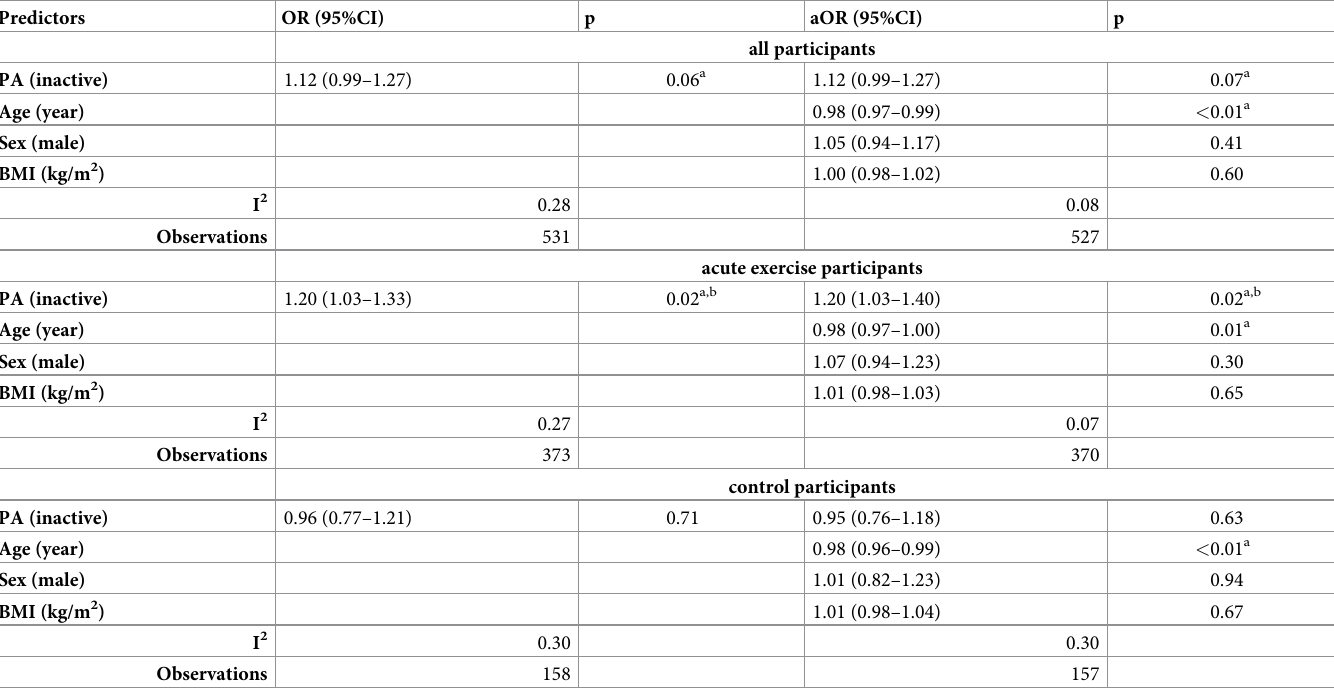
The effect of physical activity (PA) level on influenza H1 antibody titer change by acute exercise: linear regression (unadjusted and adjusted modelling) on change in antibody titer levels. Estimates are given with 95%CI in parentheses. Predictors are by unit increase (age and BMI) or versus dichotomous comparator (PA level and sex). Odds ratios are given with 95%CI in parentheses.